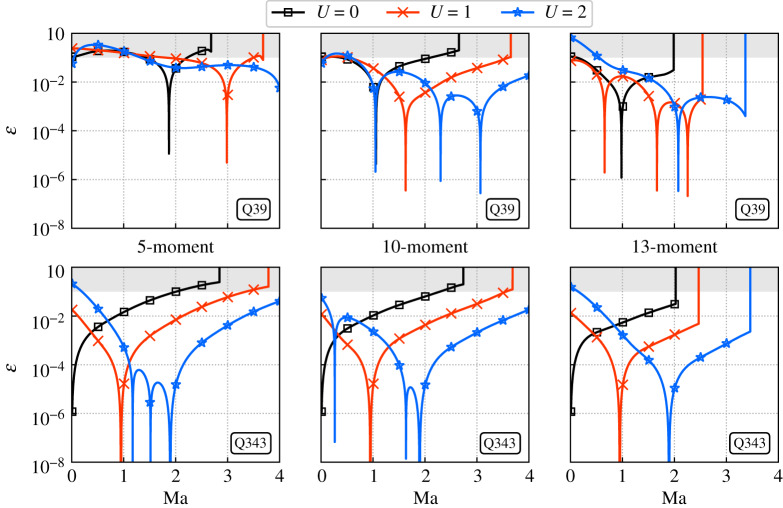
Impact of the shifted velocity U on the error ε of Mxxααeq for the 5-, 10- and 13-moment approaches (T = T0). Two lattices are considered (from top to bottom): the Q39 and Q343 lattices. The flow propagates along the x-axis. (Online version in colour.)